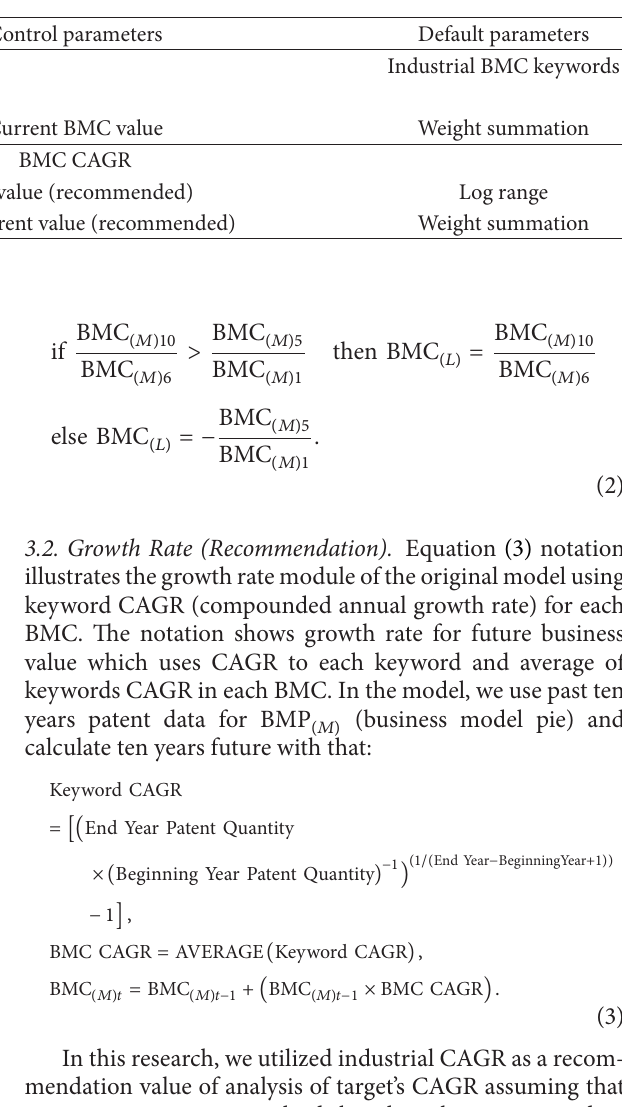
Table 2: Original model and simulation control and default parameters.